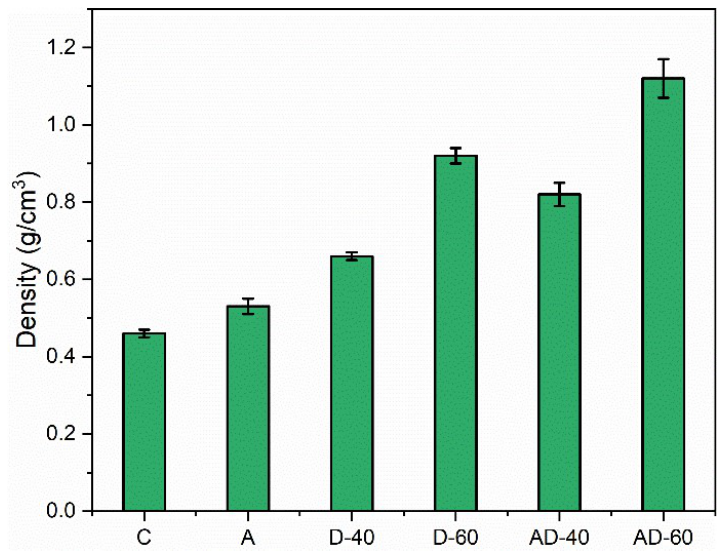
Figure 5. Densities of control and treated wood samples.